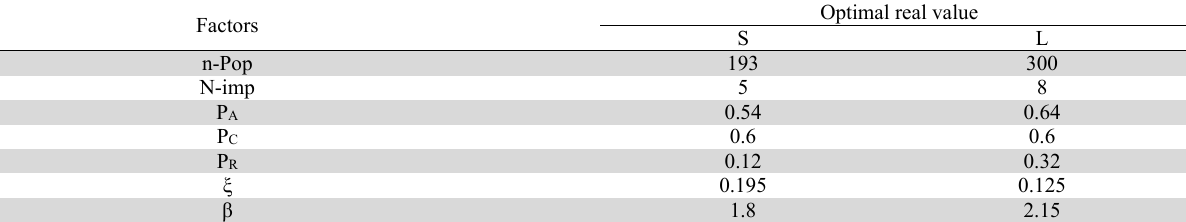
The summary of the parameter used for the proposed study